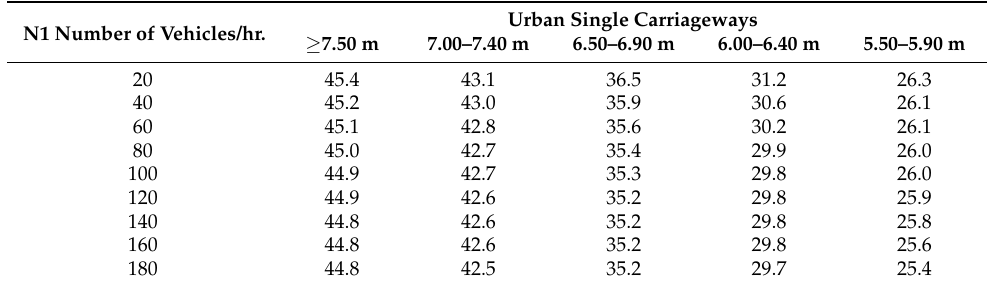
Table A2. Vehicle travel speed (km/h) on urban single carriageways depending on vehicle traffic flow N1 (vehicles/hour). N1 Number of